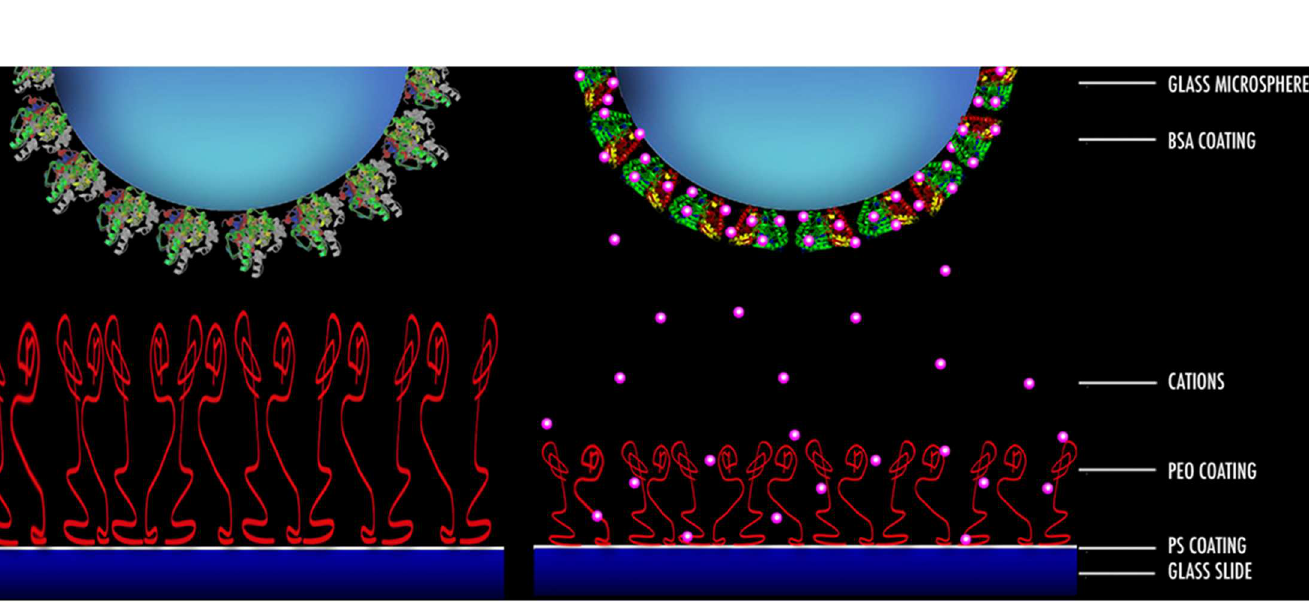
PLOS ONE | https://doi.org/10.1371/journal.pone.0173910 March 15,